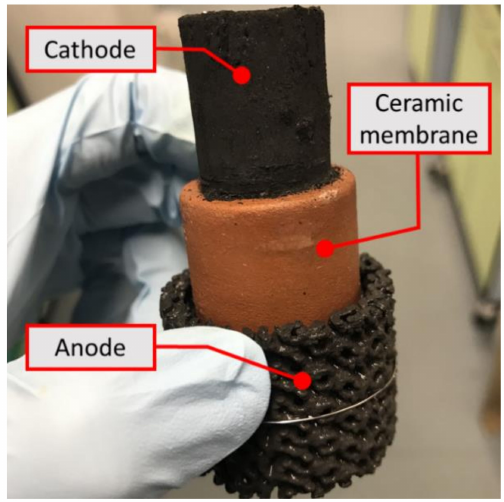
Figure 5. MFC configuration used in this study. A terracotta ceramic membrane was placed between the outer anode (3D printed anode in this photo) and the inner